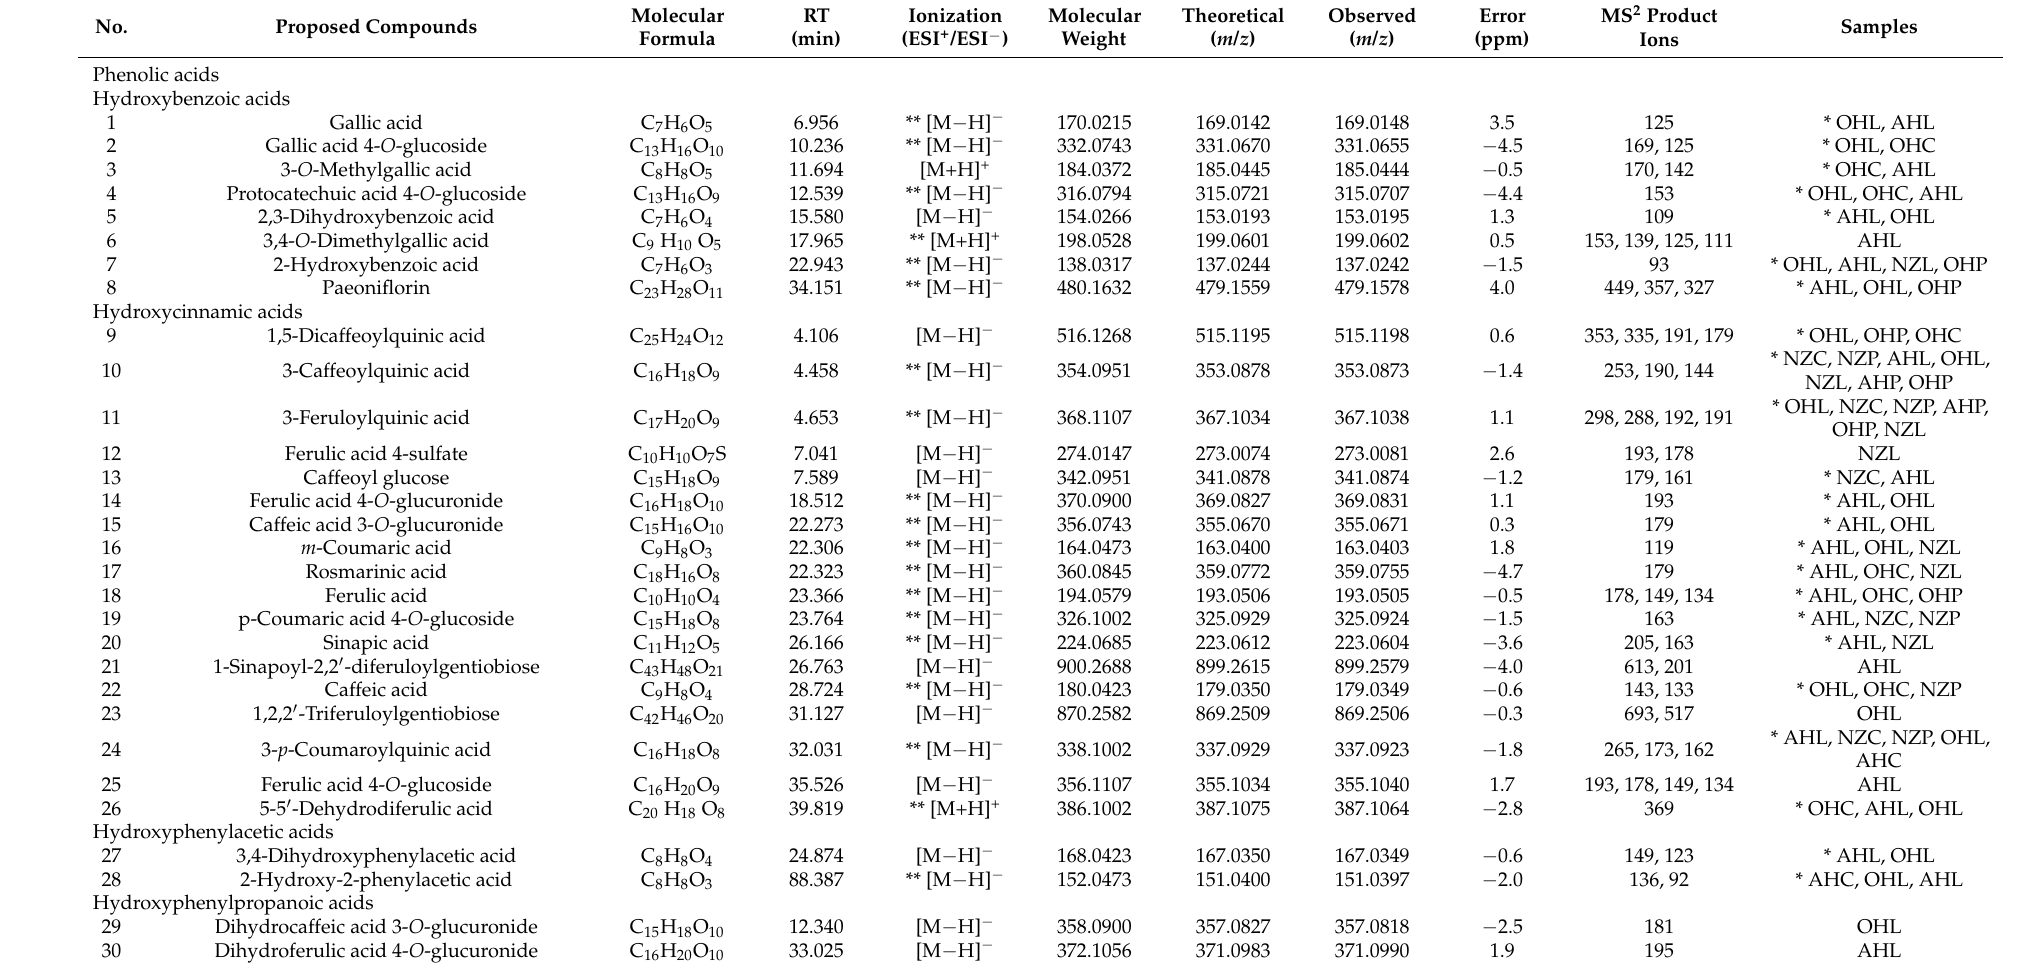
Table 2. Characterization of the phenolic compounds in the different kiwifruit samples by